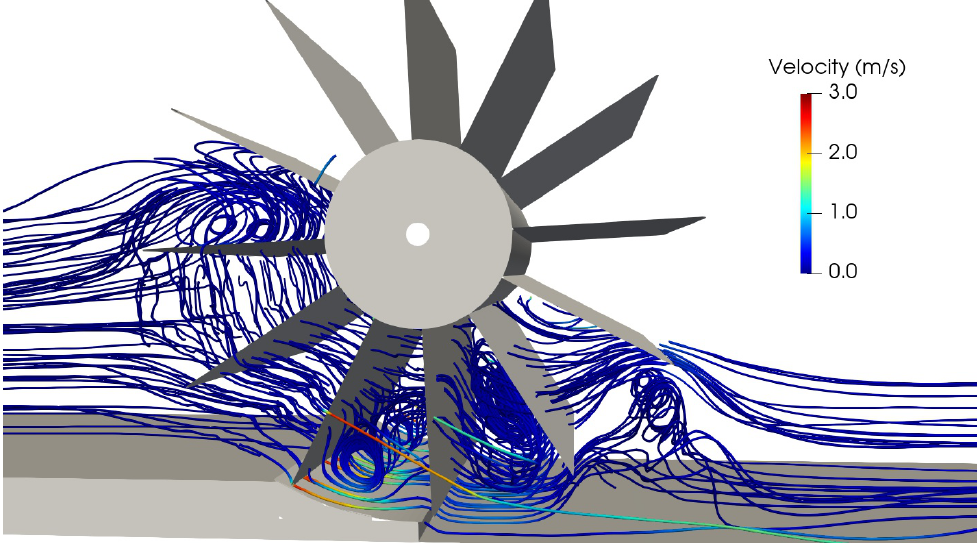
Figure 18. Image of instantaneous streamlines through the HPM colored by velocity, Q = 58.9 L/s.